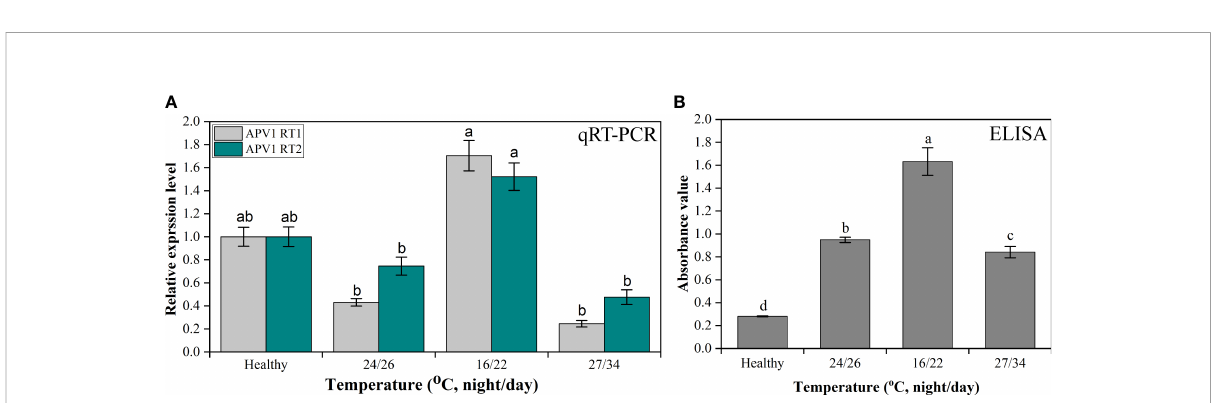
FIGURE 6 The APV1 titer accumulation analysis through (A) qRT-PCR in control (healthy), room temperature (24/26°C, night/day), low temperature (16/22° C, night/day), and high temperature (27/34°C, night/day). The primer APV1-RT1 that encodes APV1-ORF9, and APV1-RT2 that encodes APV1- ORF7 were used for gene expression analysis. (B) The APV1 titer was determined by ELISA using a polyclonal antibody against APV1 coat protein. The absorbance values of APV1-positive seedlings in different seasons under natural environmental conditions were taken at OD 450 nm using a microplate reader (BioTek Synergy H1, USA). The results were calculated according to the formula [cutoff value (P/N) = (sample OD − blank OD)/(negative OD − blank OD)]. A mean absorption value of the tested samples twice higher than that of healthy plant antigen was taken as positive for the disease. Positive controls are the mean of absorbance readings of wells containing APV1-infected areca palm leaf samples, while negative controls are the mean of absorbance readings of healthy areca palm leaves. Data presented as means ± standard error, n = 9; signi fi cant differences are exhibited by lowercase letters ( p ≤ 0.05), according to the LSD